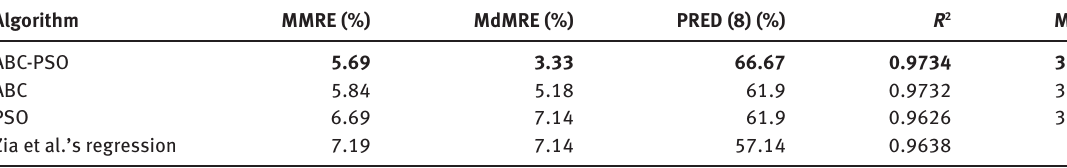
Bold text indicates that the results are statistically significant.